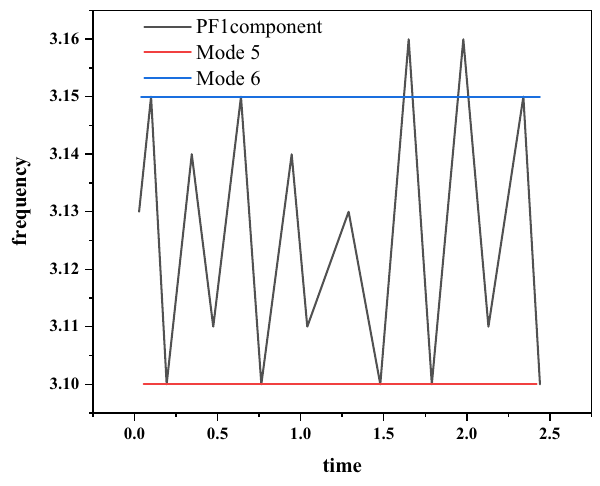
Figure 6: Frequency and contrast elements without damping.